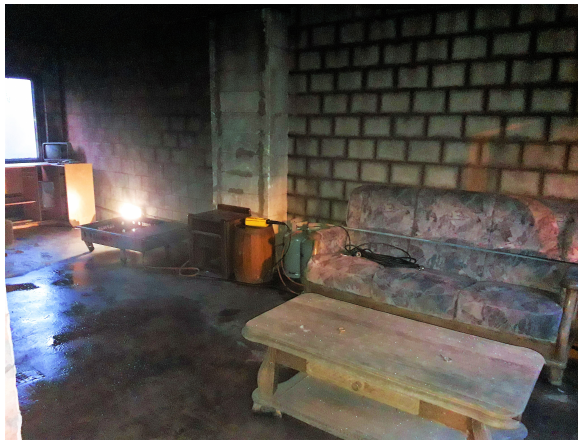
Figure 4. A picture of the inside of the testing house before it was filled with smoke. The picture is taken from the entrance.